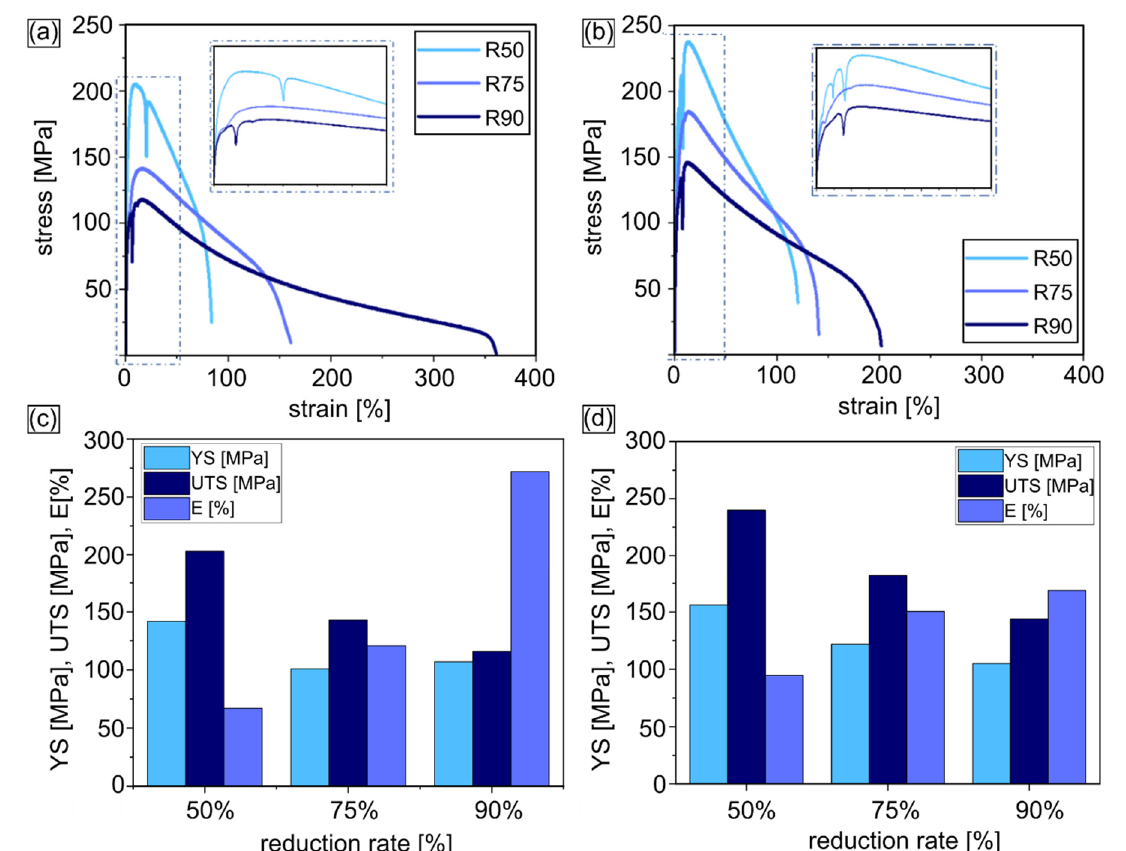
Figure 11. Strain-stress curves (for better visibility dashed line area was magnified and showed above original curves) of cold-rolled with different reduction rate Zn-1Cu alloy ( a ) and Zn-5Cu alloy ( b ) and corresponding mechanical properties ( c , d ).